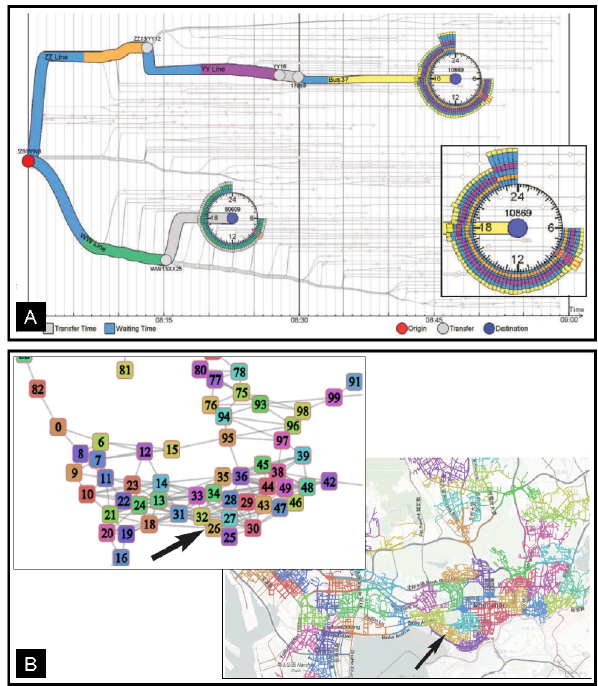
Fig. 6 (A) In a public transportation system, journeys starting from a certain station are organized into a tree, with timeline from left to right. (B) A graph visualization shows traffic links between different regions. Reproduced with permission from Ref. [68] for (A), c (cid:13) IEEE 2014; Ref. [51] for (B), c (cid:13) IEEE 2016.